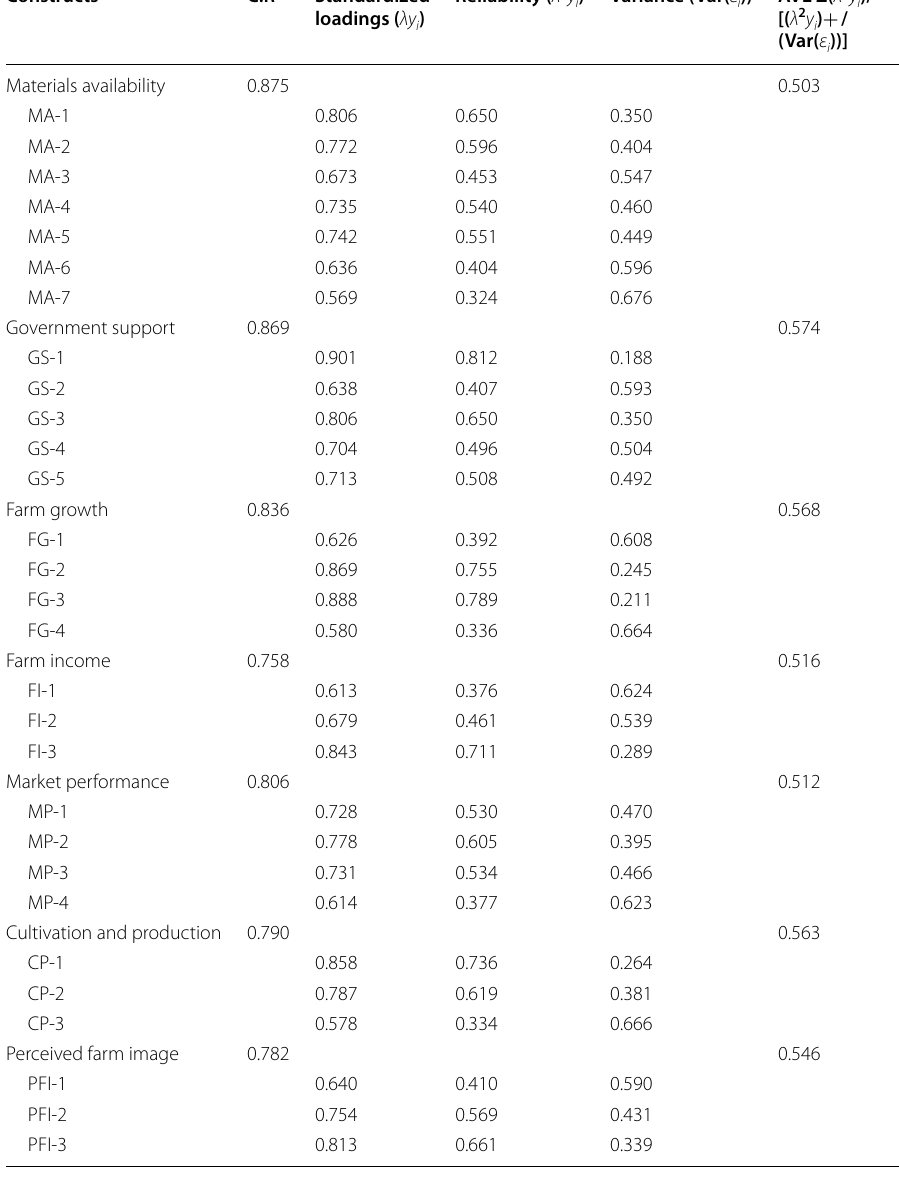
Table 5 Results of confirmatory factor analysis Constructs